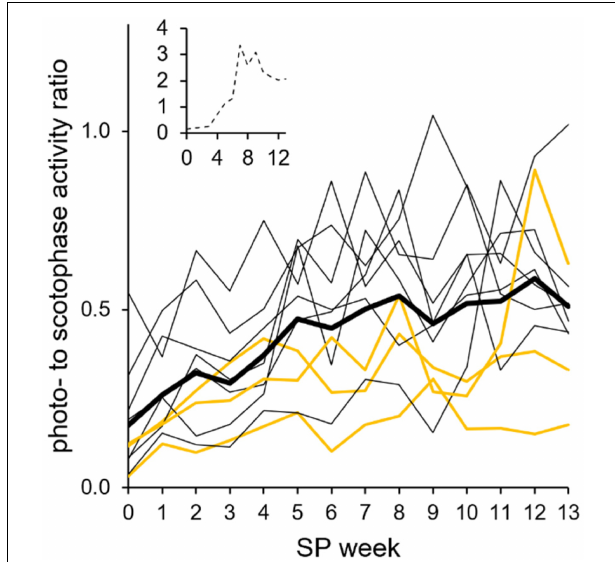
FIGURE 10 | Photophase-to-scotophase activity ratio during the short photoperiod adaptation of approach 2. For each animal and week, the photophase-to-scotophase activity ratio was calculated to identify nocturnality (ratio < 1) and diurnality (ratio > 1). Individual ratios (the three “never torpor” hamsters as yellow lines and all others as thin black lines ; inset : graph of hyperactive hamster #06) were averaged for the cohort’s ratio ( thick line ). The cohort’s ratio ( n = 10, without hamster #06) showed a positive linear correlation with progressing adaptation to the short photoperiod (SP) ( R 2 = 0.8144, r = 0.902, p < 0.05). Significant differences to SP07 before torpor expression were found in SP00 and SP01, while differences to SP12 occurred in SP00, SP01, and SP03 [Friedman repeated measures ANOVA: χ 2 ( 13 ) = 68.811, p < 0.001, with Tukey’s test p < 0.05]. The exact values per hamster can be found in Supplementary Table 7